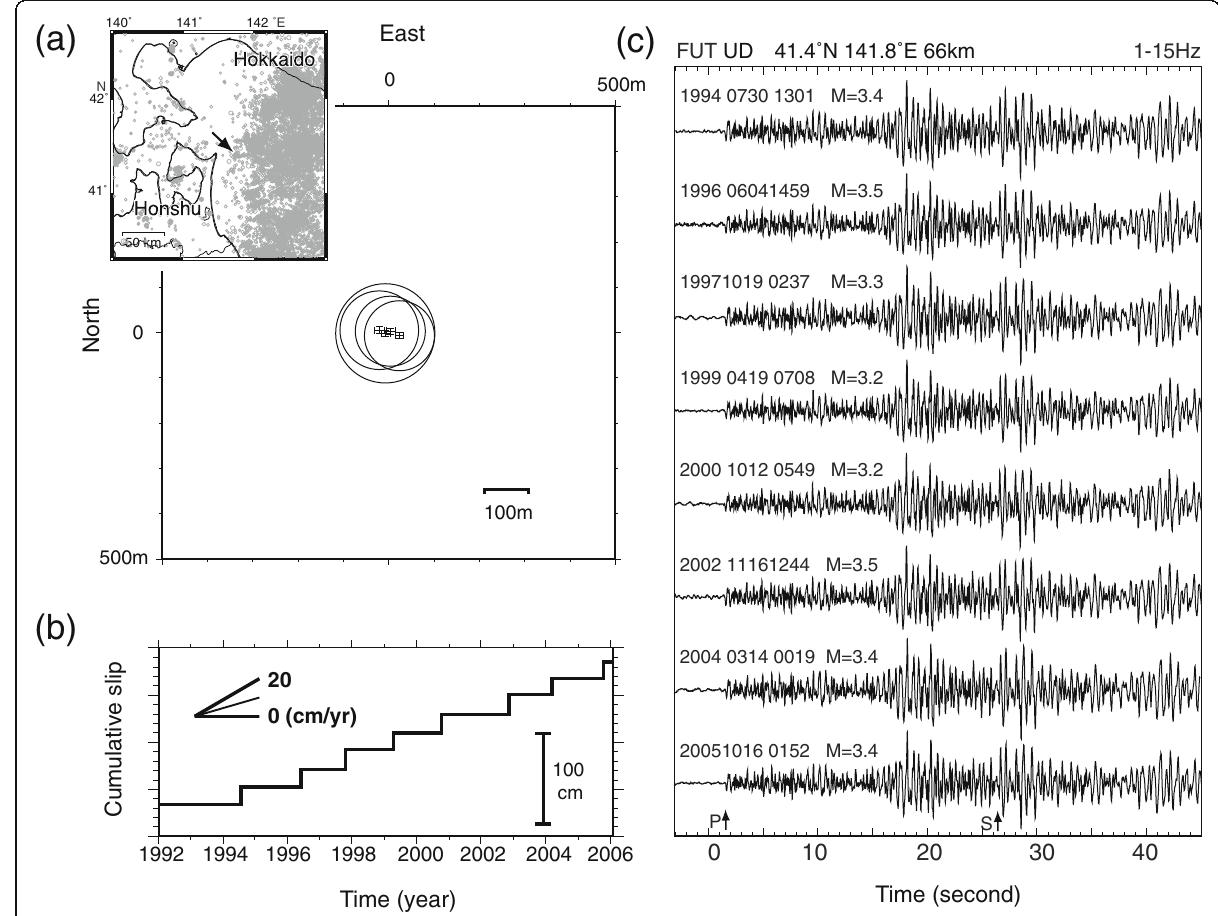
Fig. 2 An example of a repeating earthquake source locations, b cumulative slip, and c waveforms for one sequence 65 km deep in the northeastern Japan subduction zone (see inset in a for the location) (after Uchida et al. (2006)). The centroid locations are based on double- difference hypocenter estimation using the cross-spectrum method to find the precise differential time. Source sizes are estimated using a 75 MPa stress drop. The cumulative slip in b was calculated by using the seismic moment-slip relationship by (Nadeau and Johnson 1998). The waveforms in c are the vertical component observed at station FUT ( Δ = 190 km) in Honshu, Japan, filtered in the 1 – 15 Hz